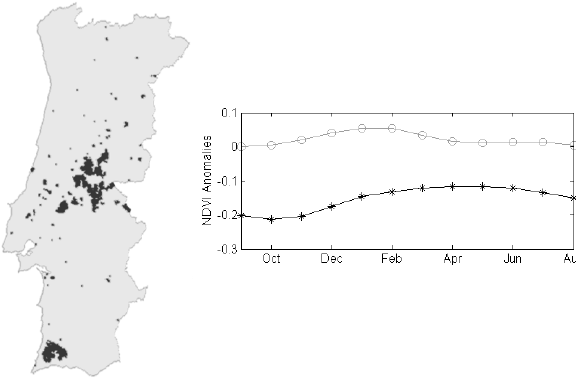
Fig. 2. Burned areas in Continental Portugal during the fire season of 2003 (black pixels in the left panel) as identified by means of cluster analysis and annual cycles of monthly MVC-NDVI anoma- lies that characterise the centroids of the two identified clusters (right panel), respectively associated to burned pixels (black solid circles) and non-burned pixels (grey open